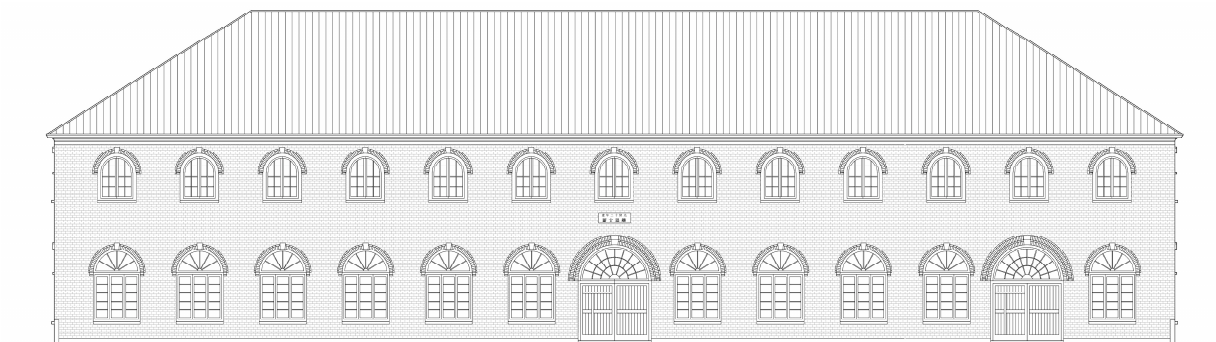
Figure 12. The main facade of the LMF. Picture by